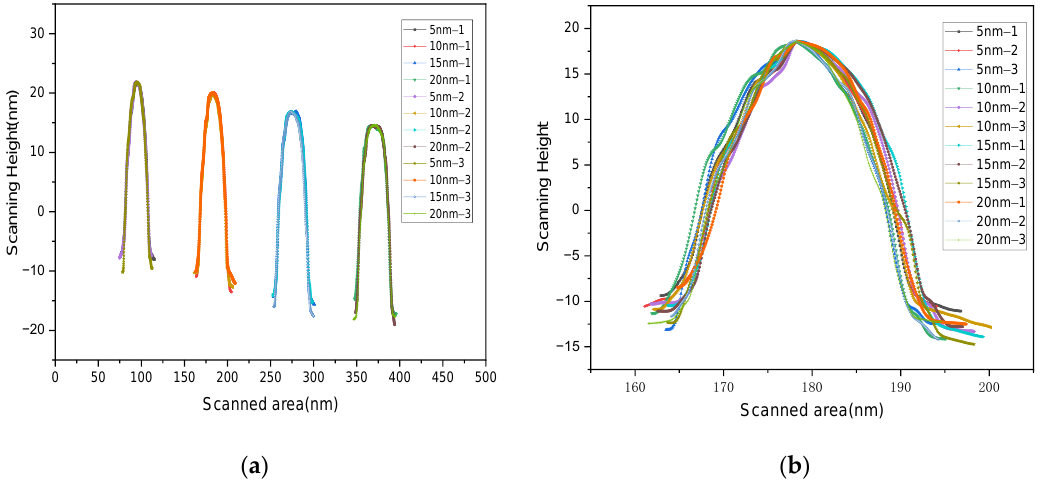
Figure 8. ( a ) Randomly selected measured profiles of the 5 nm, 10 nm, 15 nm and 20 nm linewidth tip characterizer along X direction; ( b ) AFM probe tip structure obtained along X direction by the tip characterizer.